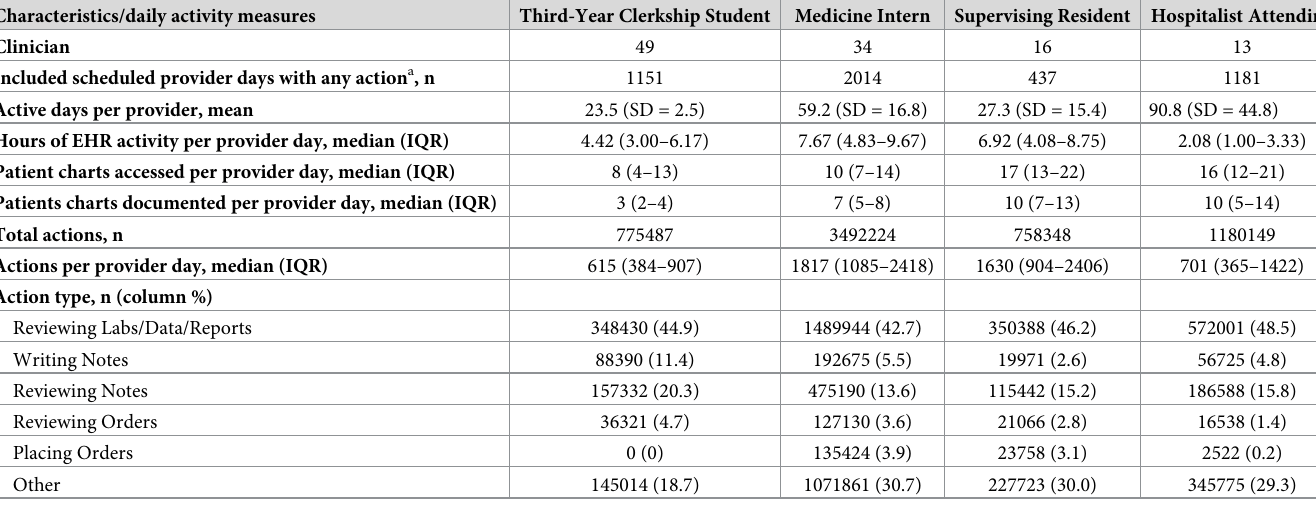
Table 1. Characteristics and daily activity measures summary by provider role.